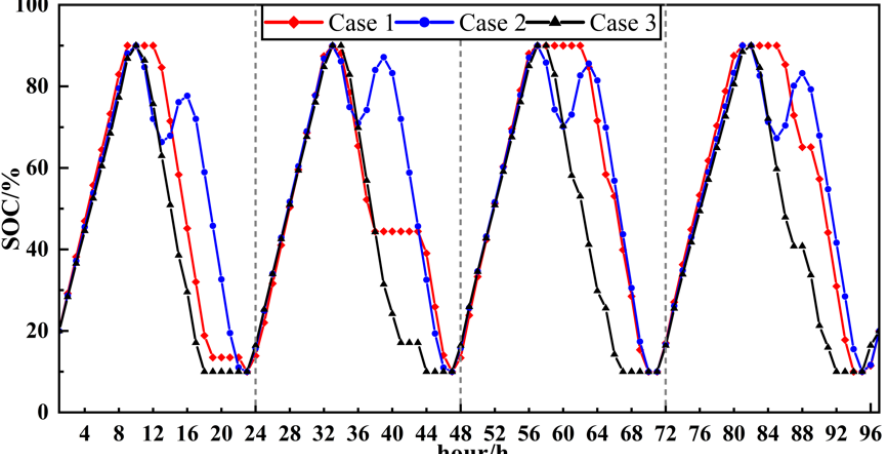
Figure 15. The total carbon emission responsibility before and after the EES configuration in three cases.